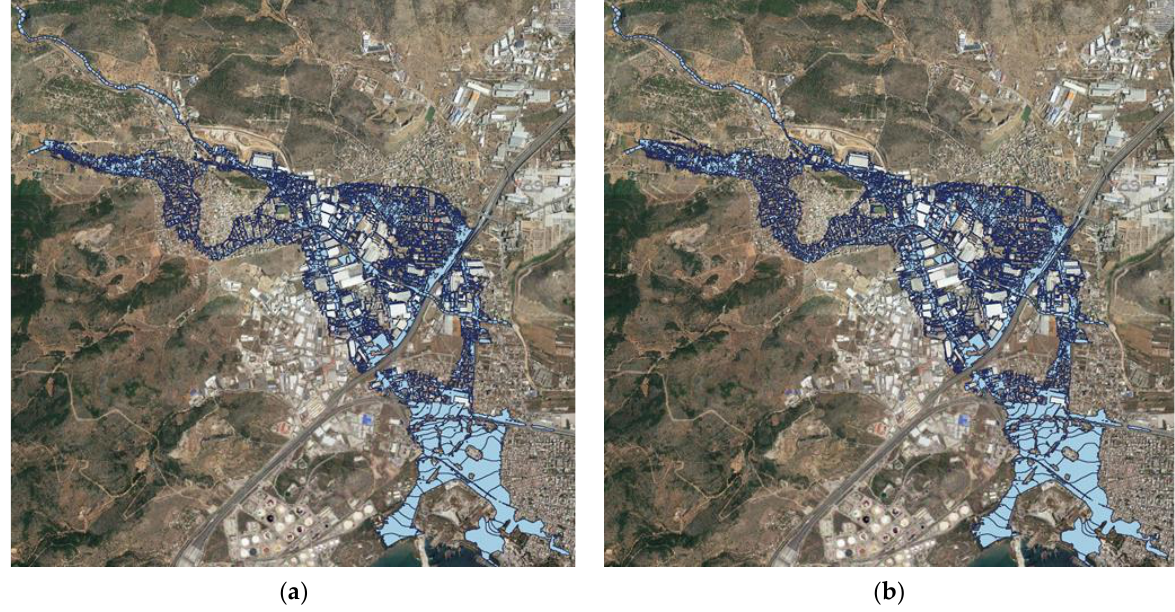
Figure 8. Comparison of inundation areas for scenarios (a) DWE-4 and (b) SWE-4.